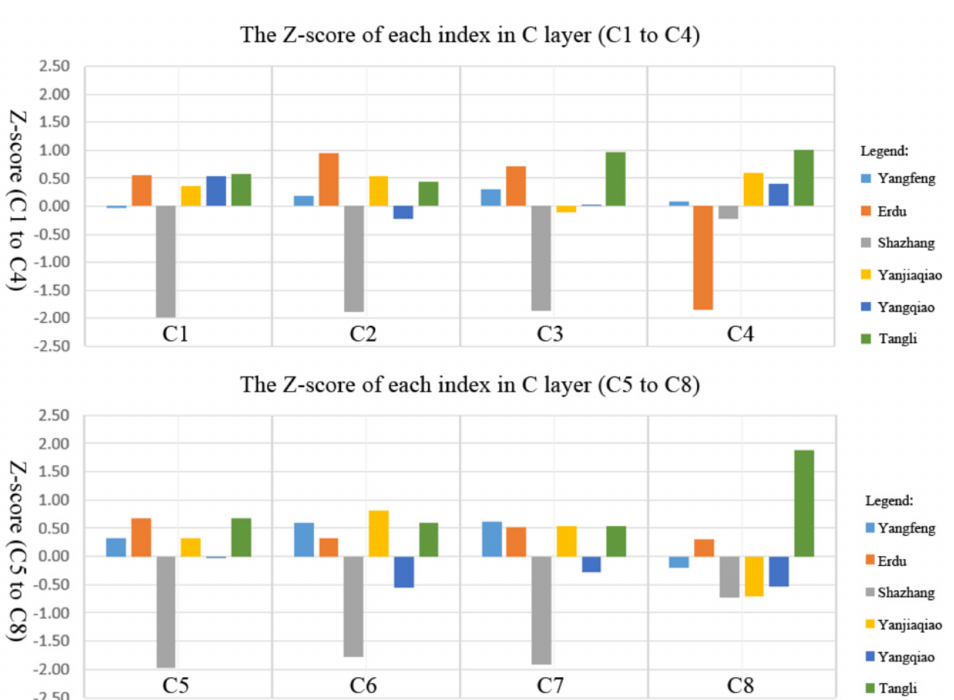
Figure 10. The Z-score of each index in C